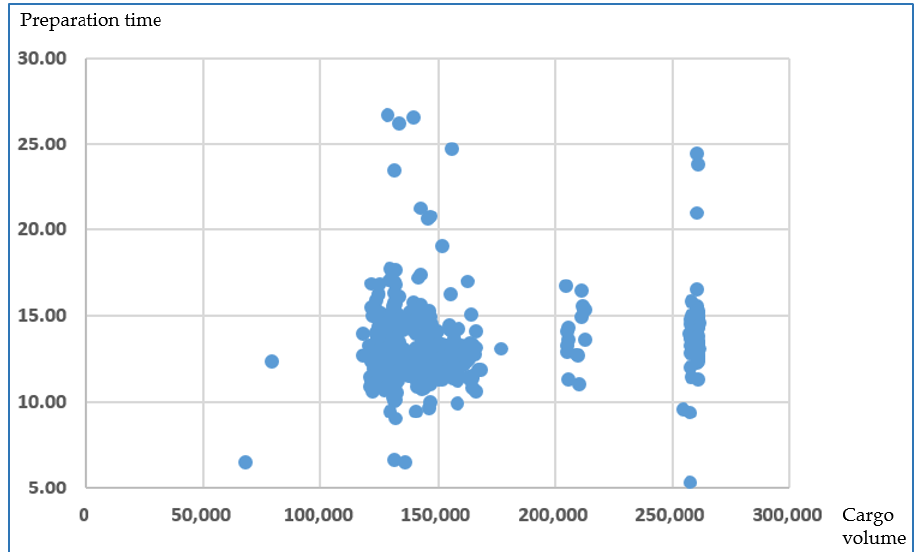
Figure 5 Regression analysis of cargo volume and preparation time. Figure 5. Regression analysis of cargo volume and preparation